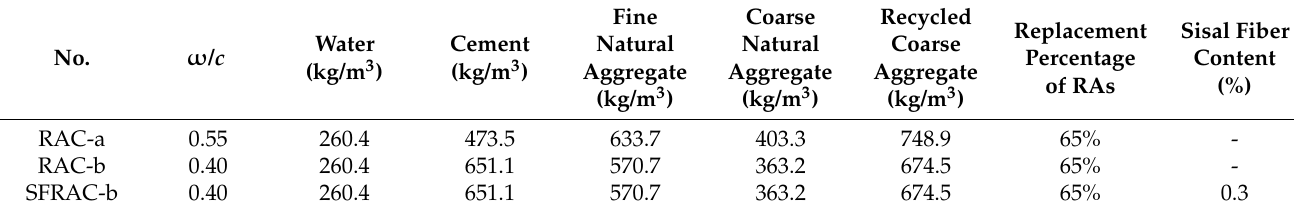
Table 4. Mix proportions of RAC and